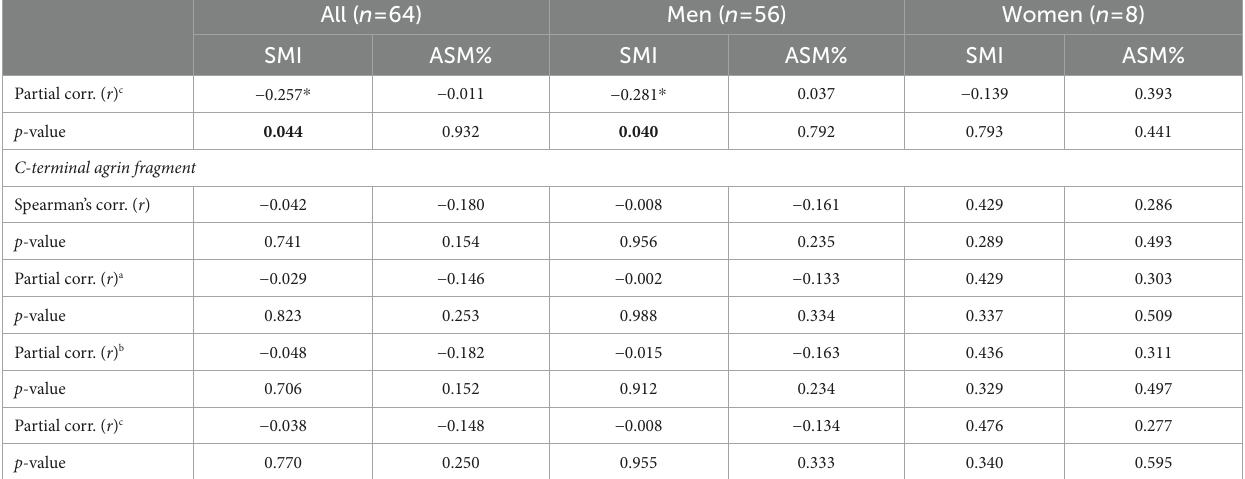
contributed to a more pronounced inflammatory environment and lean mass loss in this study (51), potentially explaining the strong association between transthyretin and SMI, compared to a non-significant association in the present study ( r = 0.246, p = 0.05).